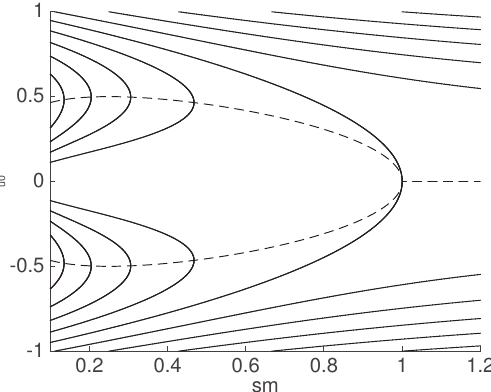
Figure 1. Illustration for Problem (8). The level curves report the cost of (8) as a function of u 0 and Σ Σ = 1. The dashed lines report the optimal input u meas , with 0 Σ meas low enough, the problem has two non-zero